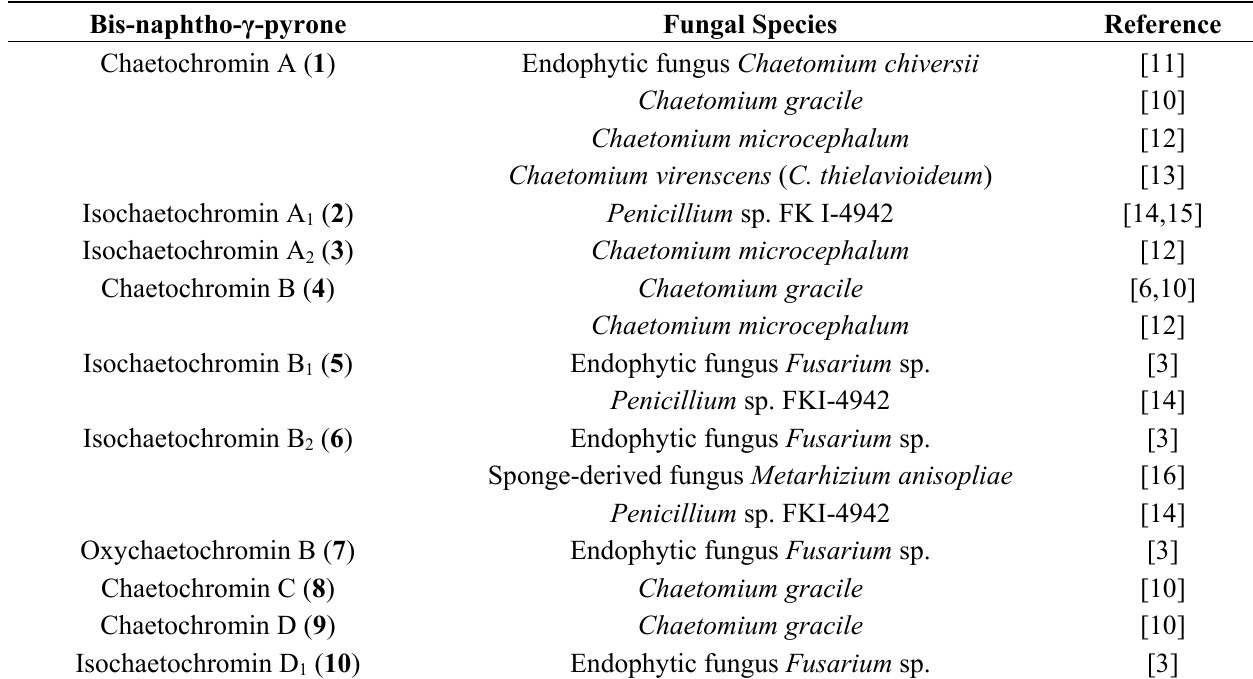
Table 1. Occurrence of chaetochromin-type bis-naphtho- γ -pyrones 1 – 26 in fungi. Bis-naphtho- γ